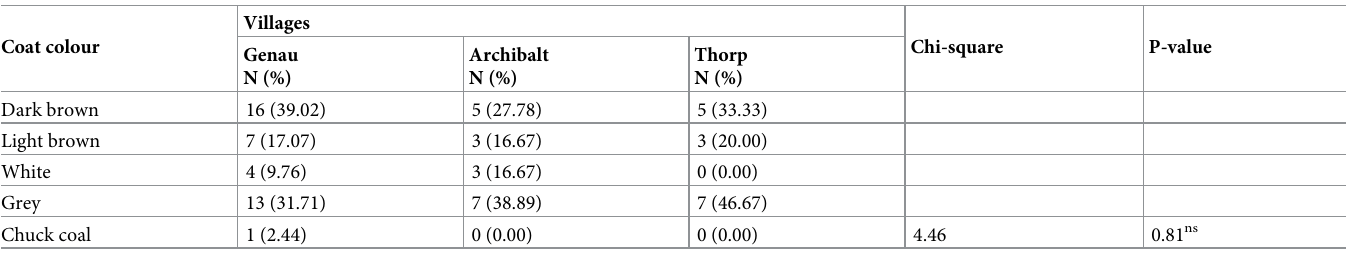
Table 6. Donkey colour